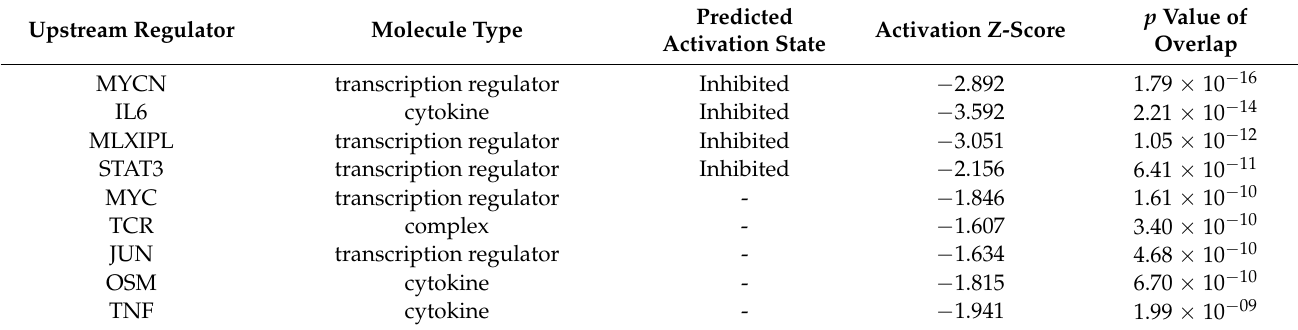
Table 4. Upstream regulators predicted by IPA.